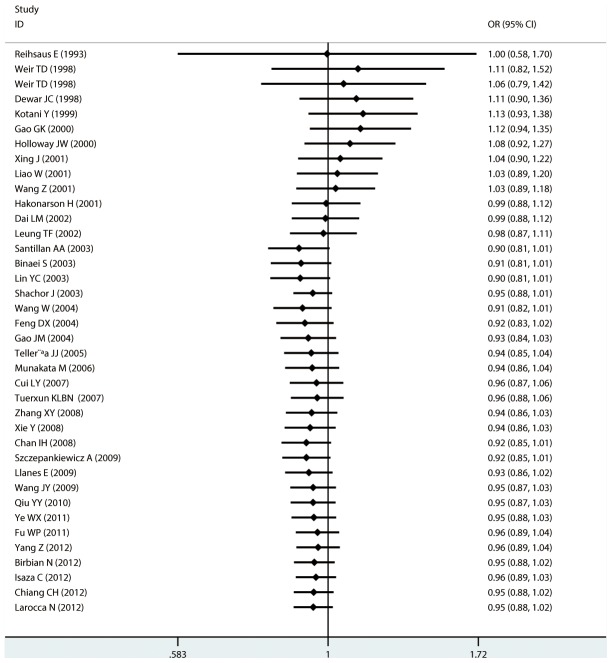
Forest plots of cumulative meta-analysis of Gln27Glu (rs1042714)in association with asthma by published year under allele comparison.